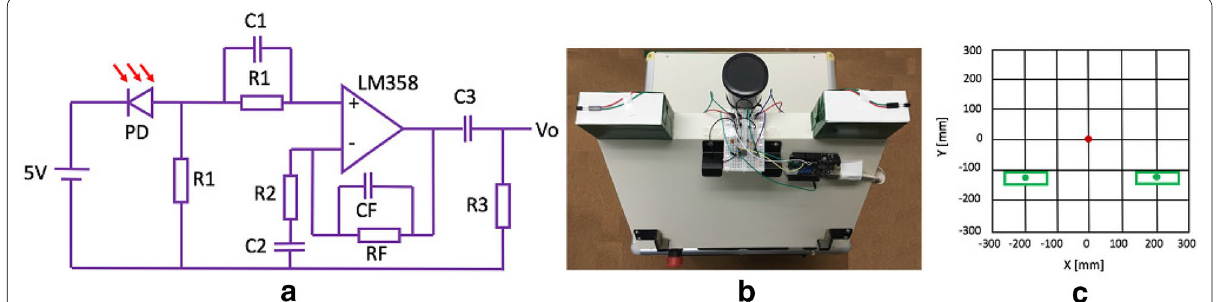
Fig. 4 Details of the receiver. a Circuit of the receiver, which consists of a reverse bias circuit and non-inverting amplifier; b top view of the mobile robot with two photodiodes; c geometric relationship between the receivers and the robot in 2D